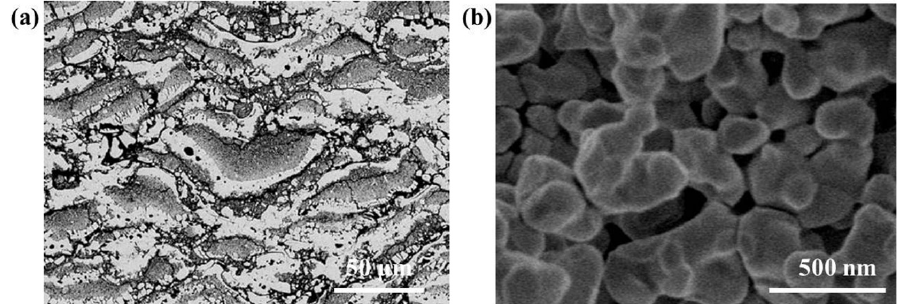
Fig. 79 Nanostructured TBCs: (a) bimodal structure of lamellar zones and nanozones and (b) nanozones at high magnification. Reproduced with permission from Ref. [379], © ASM International